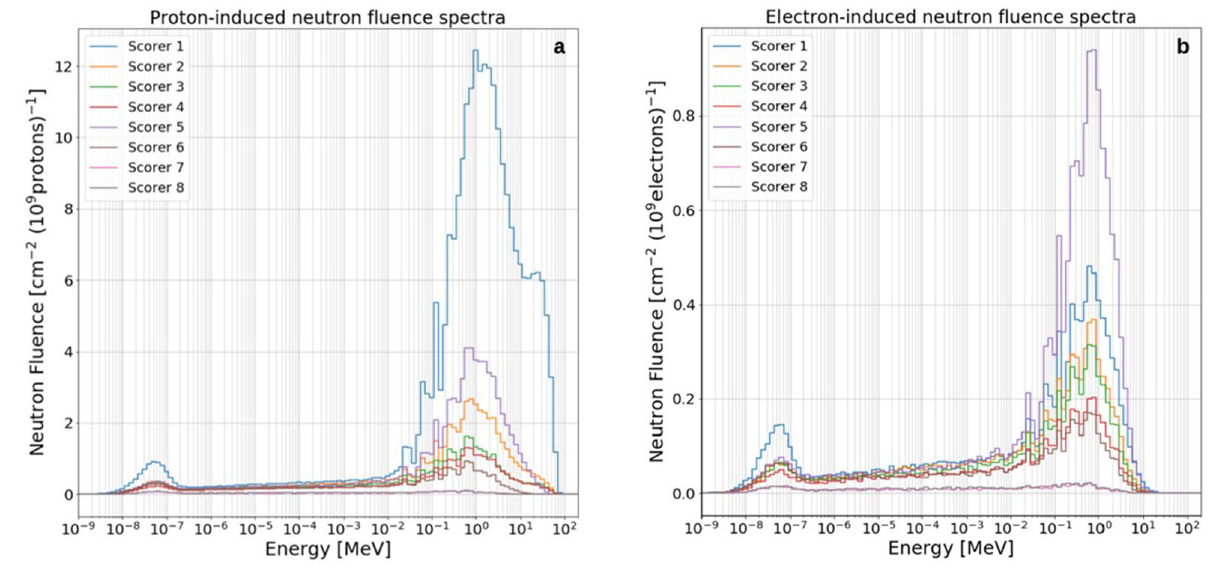
Figure 9. Proton- ( a ) and electron-induced ( b ) neutron fluence spectra for all scorers inside the LION cave (Fig. 2) using Wagner2016 input parameters. Values are normalized to 10 9 primary particles.